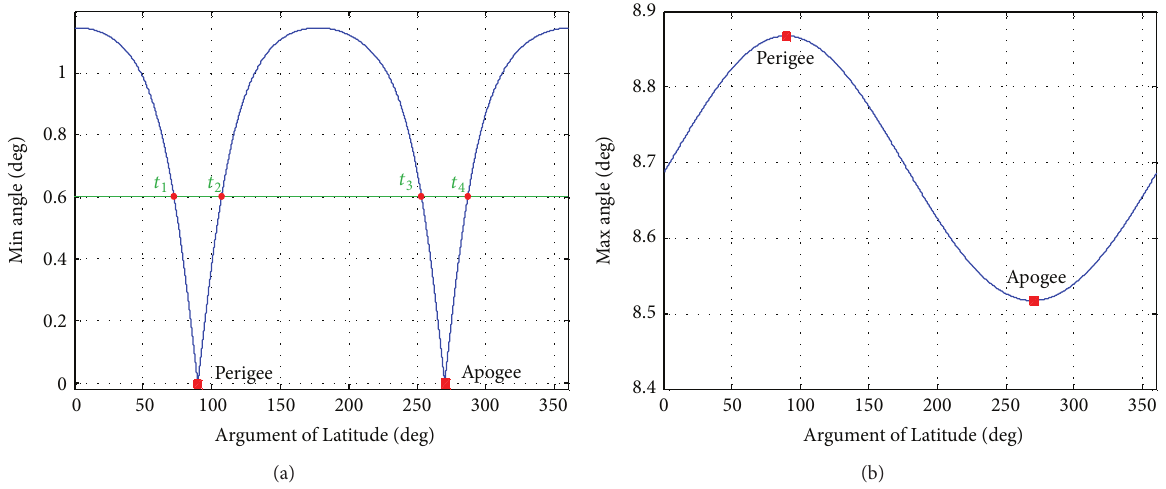
Figure 6: The effective look angles of the zero-Doppler centroid control along the orbit. (a) Minimum value of the look angle; (b) maximum value of the look angle.